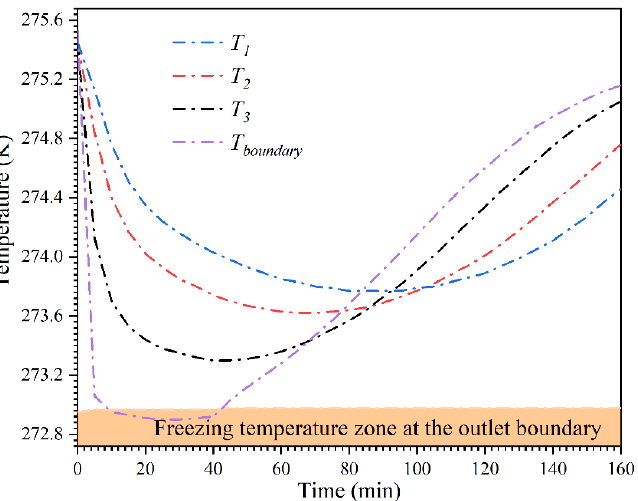
Figure 6. The temperature data at 1 mm ( T boundary ), 75 mm ( T 3 ), 150 mm ( T 2 ) and 225 mm ( T 1 ) from the outlet boundary when the outlet boundary pressure is set to 2.4 MPa.